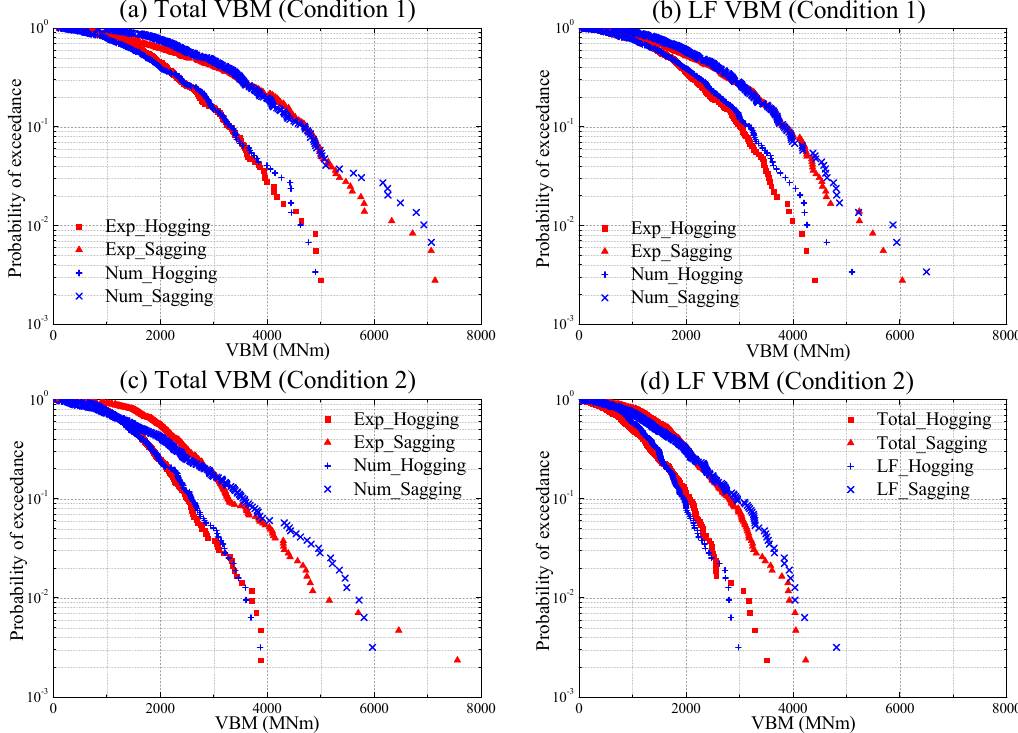
Figure 12. Probability of exceedance of total VBM peaks.